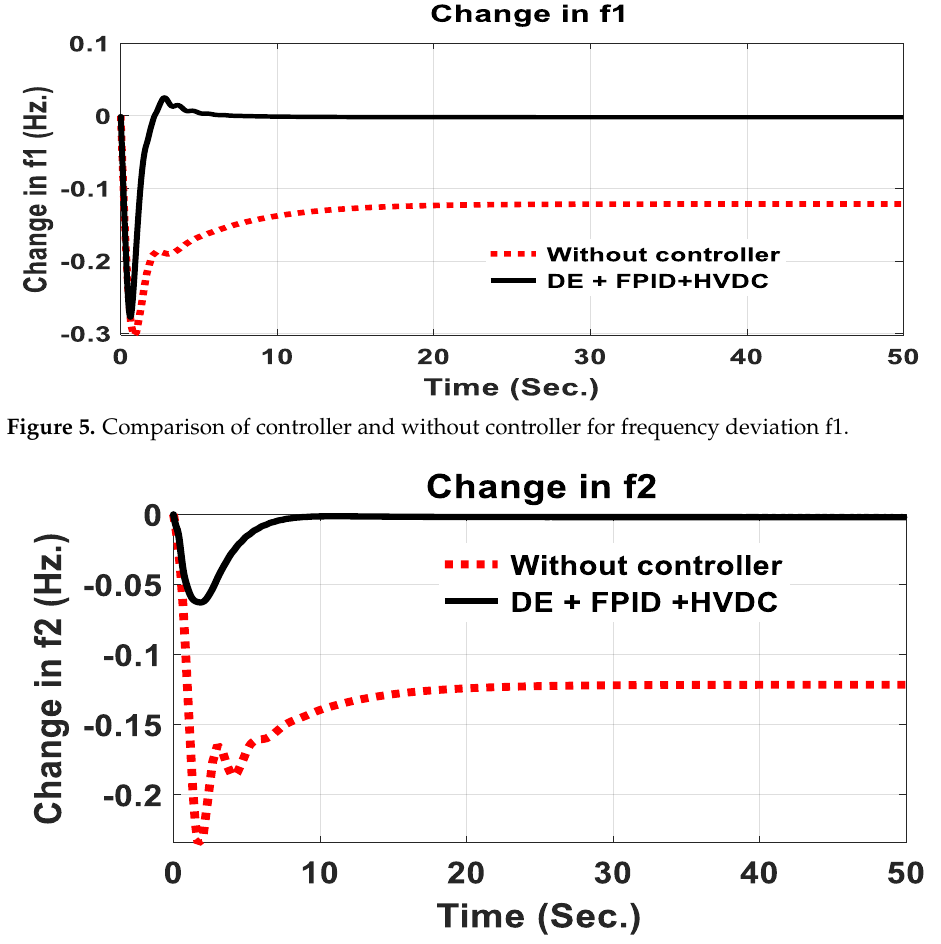
Figure 6. Comparison of controller and without controller for frequency deviation f2.